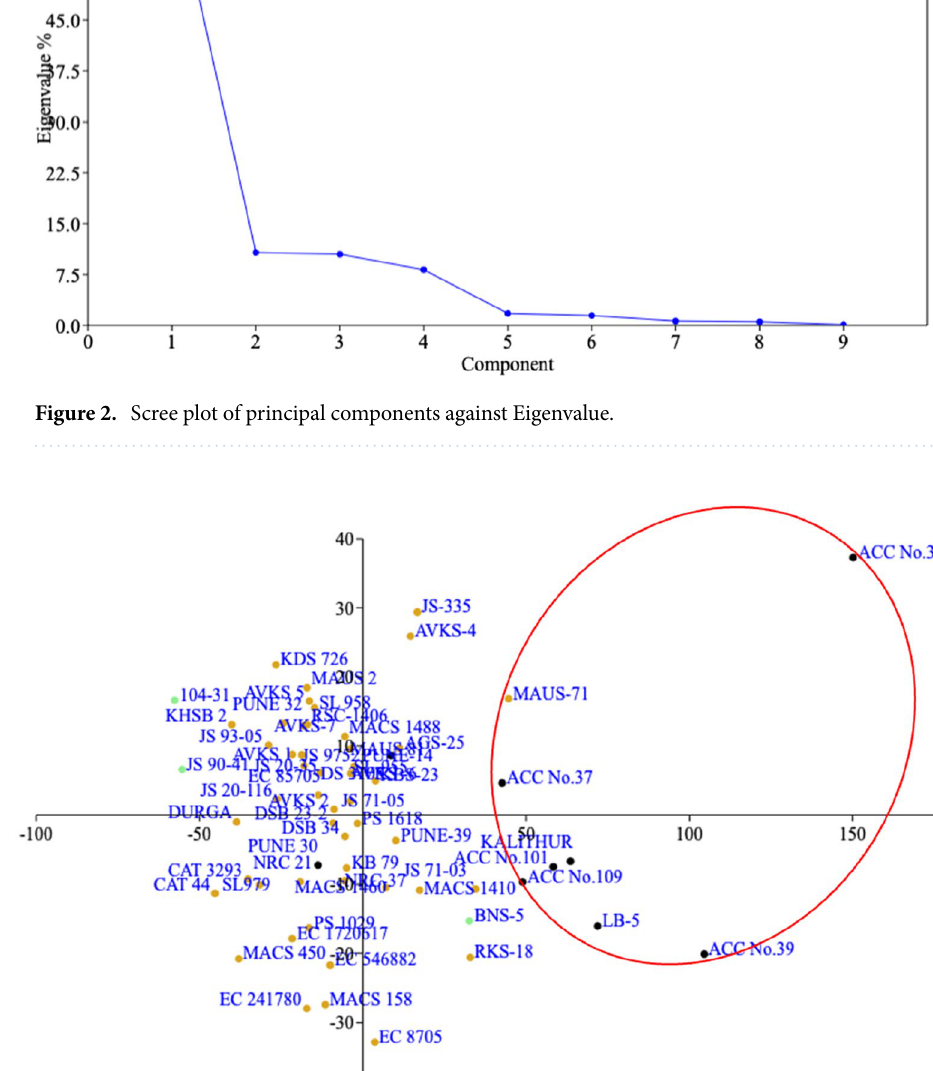
of natural ageing with accelerated ageing in both the years. During the year 2019, the highest correlation was observed after 20th month of natural ageing (0.506) followed by 16th month of natural ageing (0.496). Similarly, during the year 2021, a higher correlation was found in 12th month (0.433) followed by 14th (0.432), and 16th (0.429) months. The genotypes were grouped into five longevity ranks using the empirical rule which is also called as three sigma rule. The number and list of genotypes in each of the seed longevity classes are given in Table 4. The highest number of genotypes fell into SR 3 rank in both natural and accelerated ageing. More than 40 genotypes were grouped in SR 3 rank in all the months of testing under natural ageing. Forty two genotypes in accelerated ageing during the year 2019 and 38 genotypes during 2021 were observed in SR 3. None of the genotypes were found